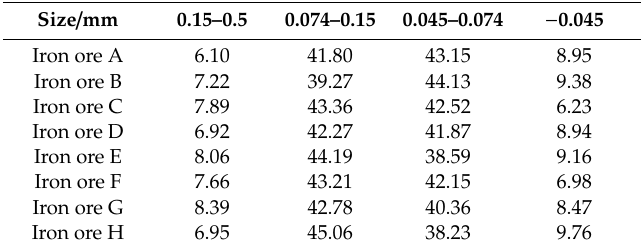
Table A1. Detailed data of size distributions of iron ores.